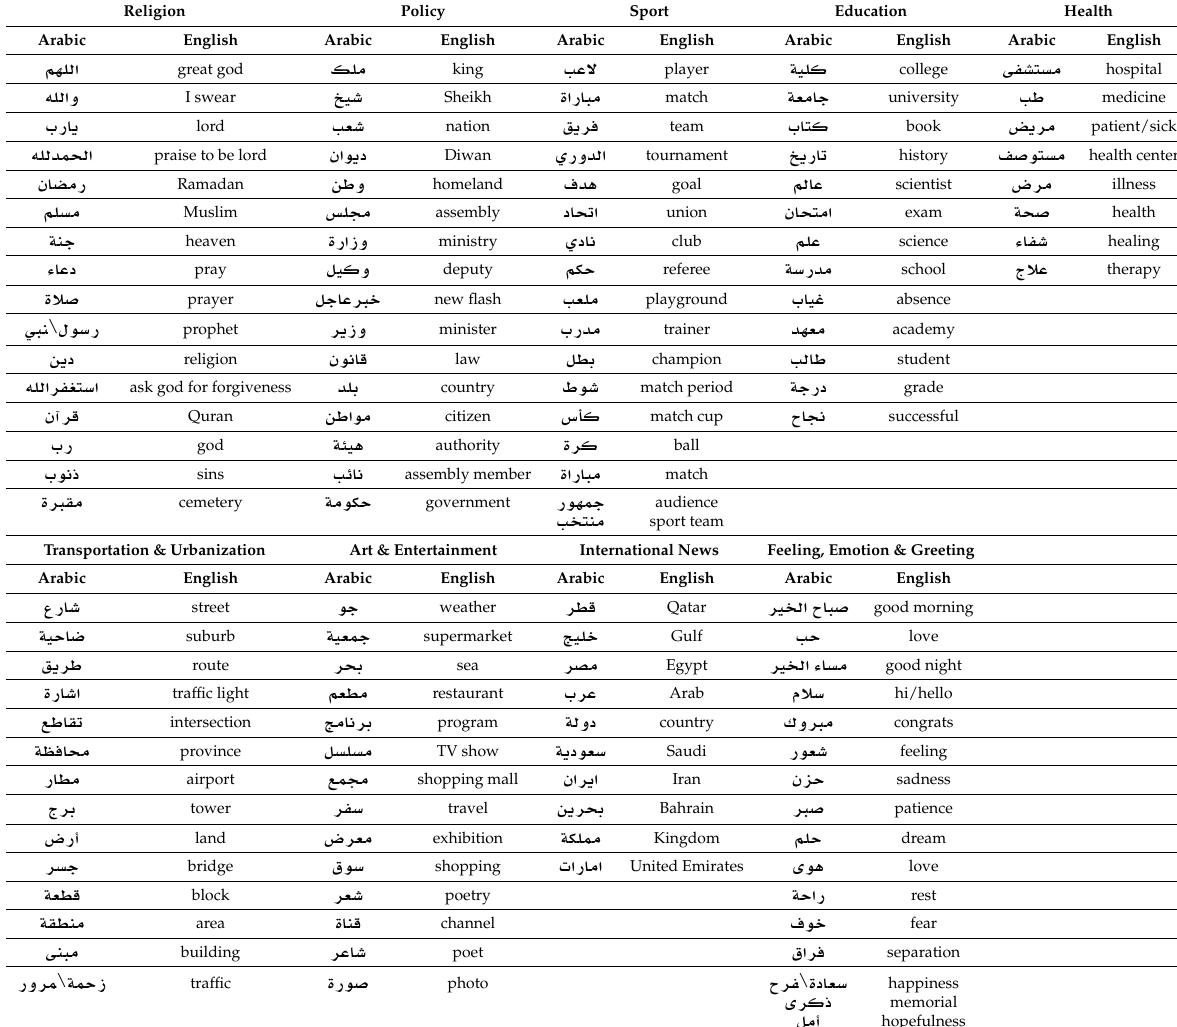
Table 3. The nine top topics of interest and their corresponding